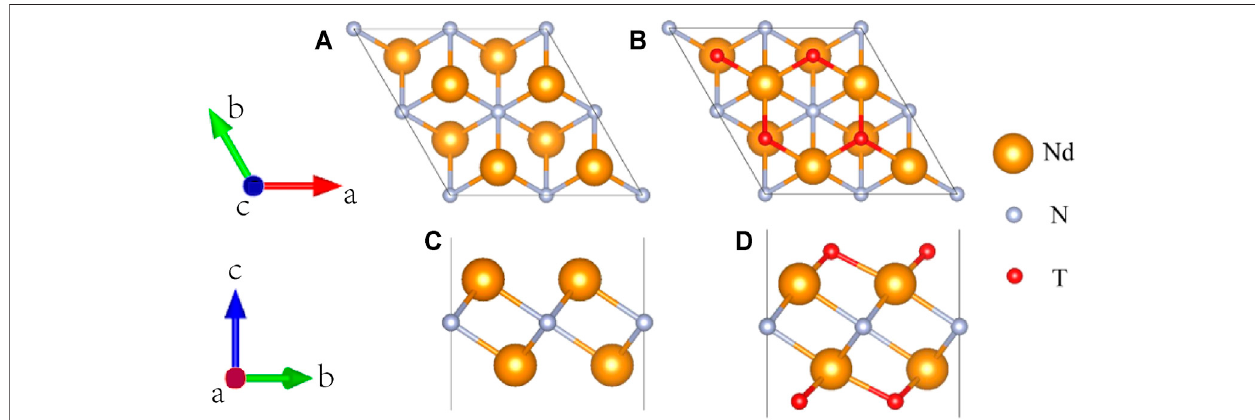
FIGURE 1 | Diagram of the structure of the 2 × 2×1 supercell of the two-dimensional MXene materials (A,C) Nd 2 N and (B,D) Nd 2 NT 2 (T = OH, O, S, F, Cl, and Br). (A,B) top views; (C,D) side views.